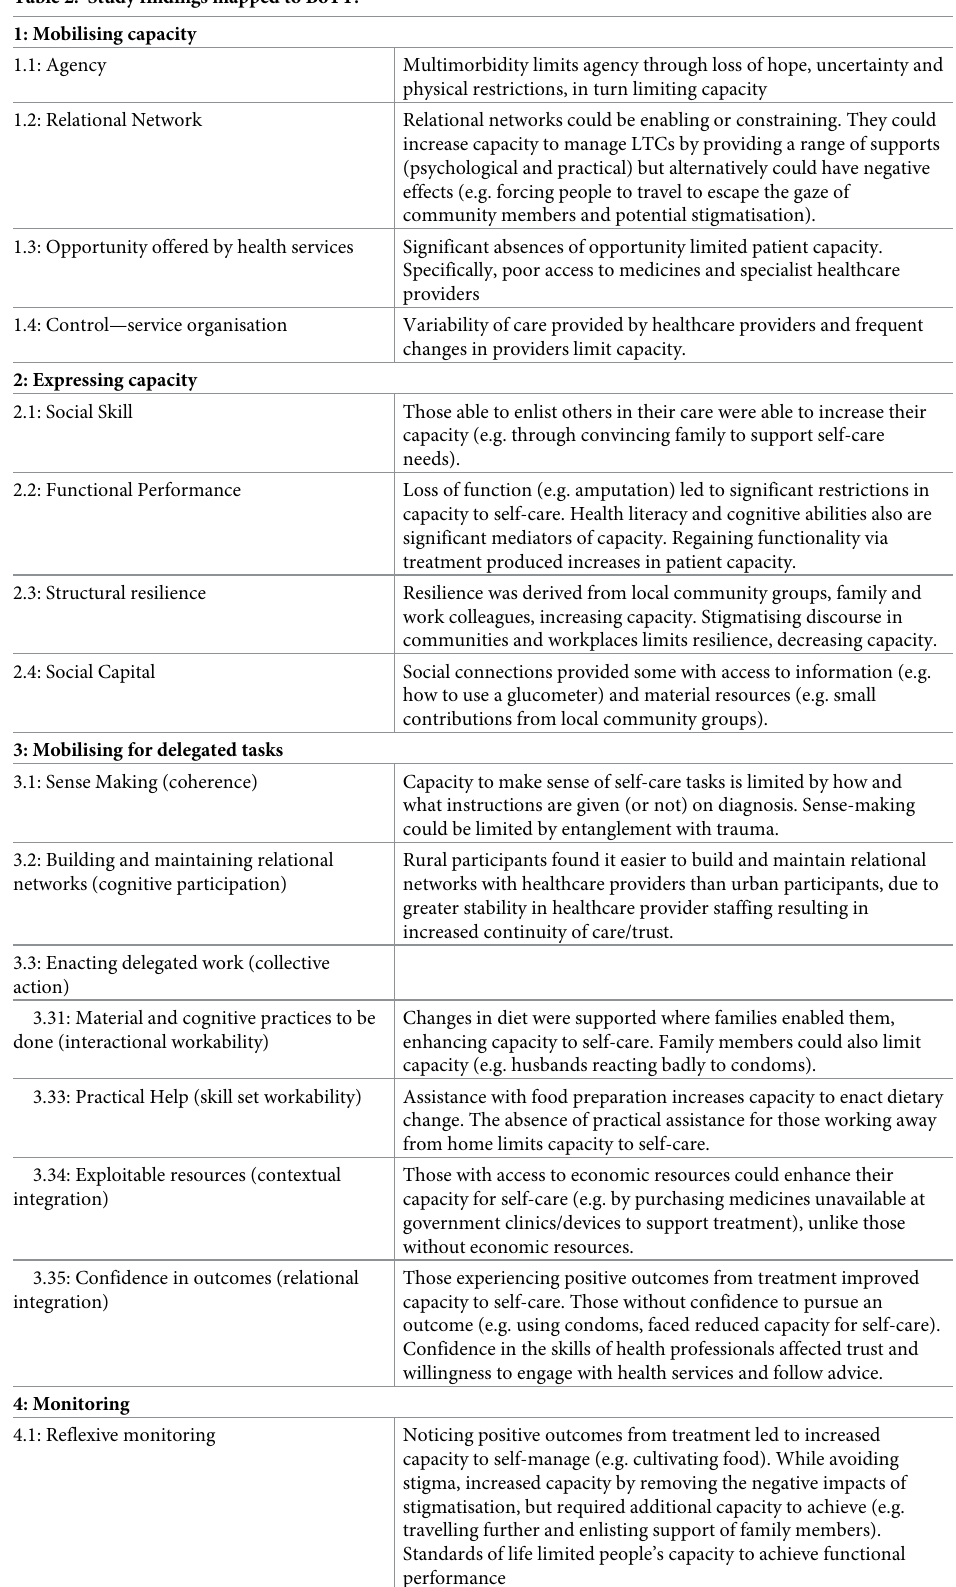
Table 2. Study findings mapped to